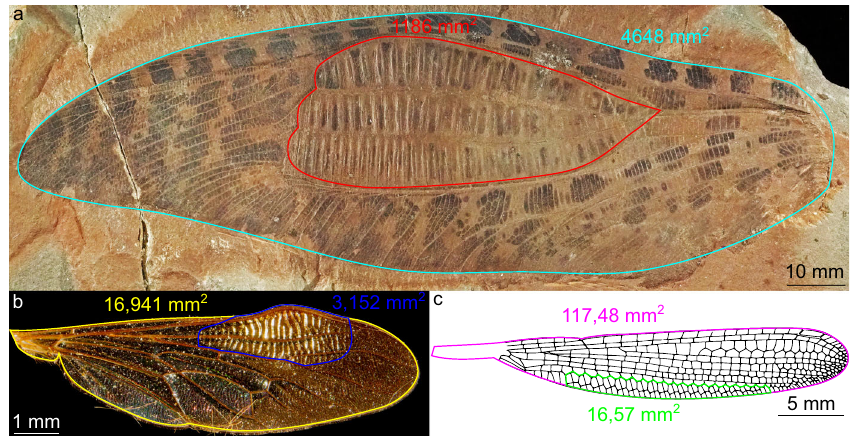
Fig. 7 Surfaces of putative wing re fl ectors in several insects. a Clatrotitan andersoni . b Ommatius torulosus . c Aulliella crucigera . The specialized zone of Clatrotitan is proportionally larger that in